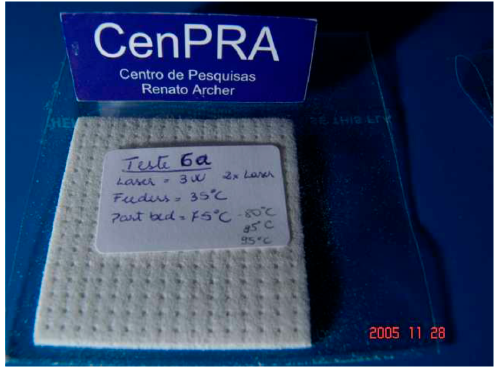
Figure 6. Sintered PHB using SLS containing pores of 1 mm in diameter [66].